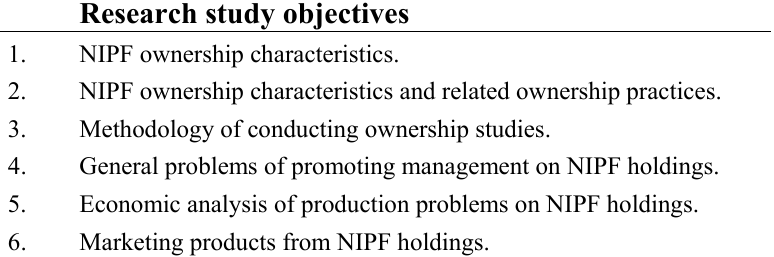
Table 1. Early nonindustrial private forest (NIPF) research literature classification scheme by study objectives